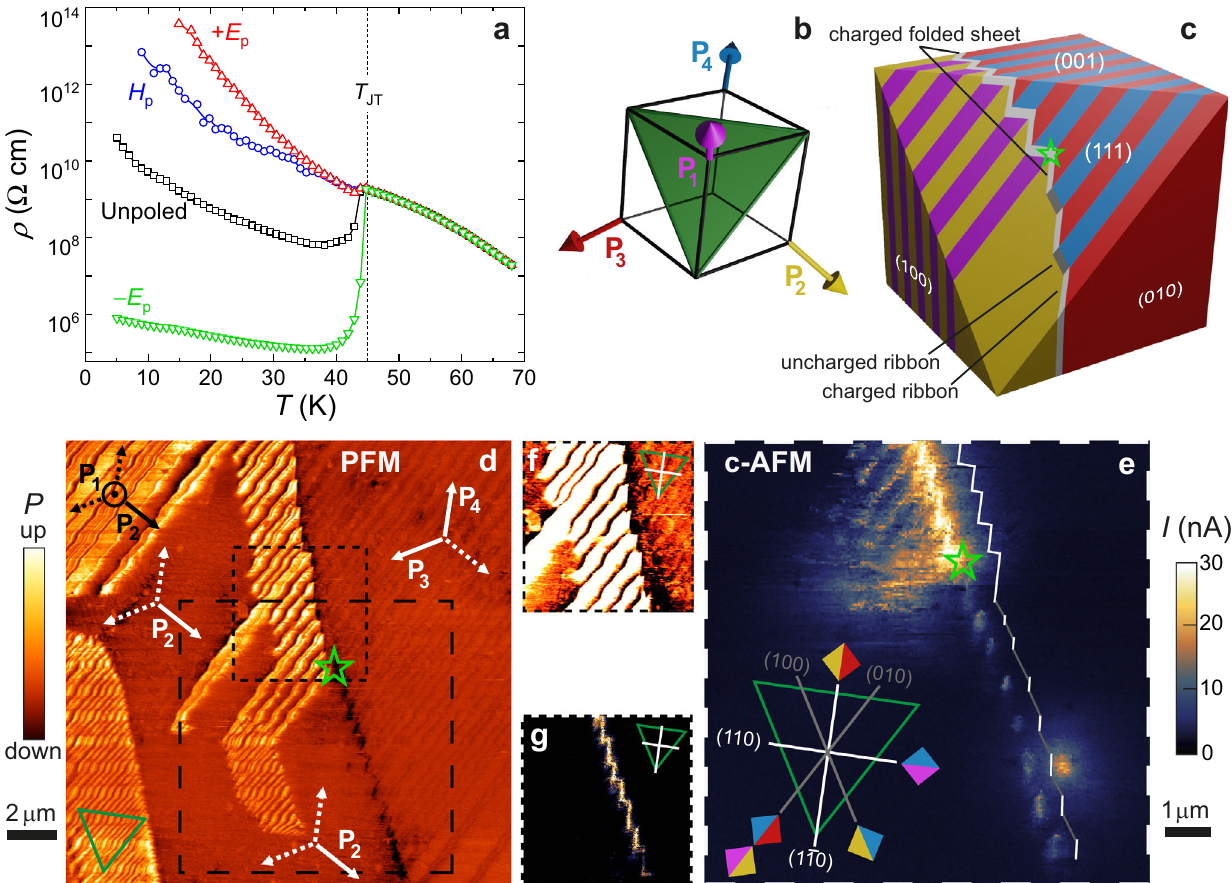
Fig. 2 Macro- and microscopic signatures of conductive DWs in GaV 4 S 8 . a Dependence of the resistivity on electric ( E p = ±5.5 kV/cm) and magnetic ( μ 0 H p = 14 T) poling below T JT , implying the presence of conducting DWs. b Orientation of the polarization in the four polar domains, P 1 – P 4 , with respect to the (111) plane (green triangle), which was imaged by PFM and c-AFM. c Schematic representation of the domain pattern observed in ( d – g ). The crystal orientation and the coloring of the domains are according to ( b ). White and gray DW segments indicate charged (TT or HH) and uncharged HT junctions, respectively. d PFM image recorded at 15 K on the (111) surface of an unpoled sample. The polarization directions for domains present/absent in the local domain patterns are indicated by solid/dashed arrows with labeling and orientation according to ( b ). e The c-AFM image, recorded over the region with the thick dashed frame in ( d ), con fi rms the conducting nature of the ribbon- and folded sheet-like DWs, where the folded sheet is a hybrid of alternating HH and TT nanoscale conducting segments, located below and above the green star, respectively. The schematic inset indicates the orientations and assignments of the DWs observed in ( d , e ) as well as in the zoomed-in color-thresholded PFM and c-AFM images of ( f , g ), both corresponding to the region with the thin dashed frame in ( d ). Orientation and color coding follows those in ( b , c